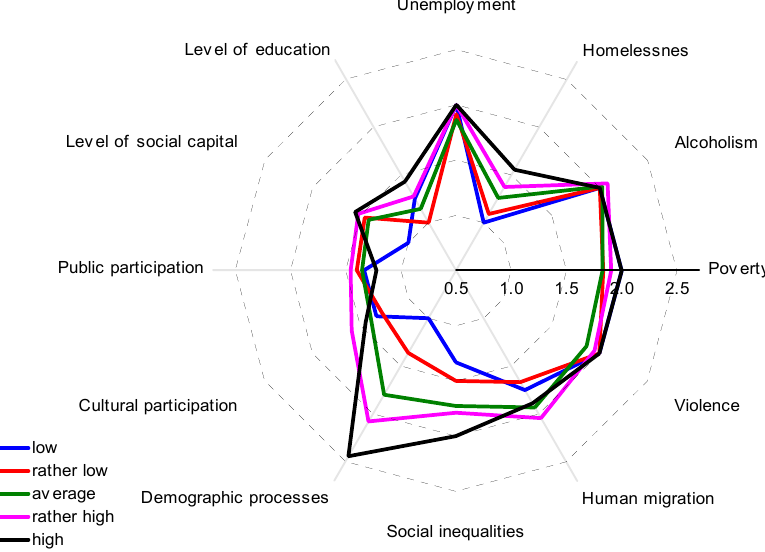
Figure 4. The prevalence of selected social issues in the analysed municipalities depending on the assessment of intensity of the ageing process.